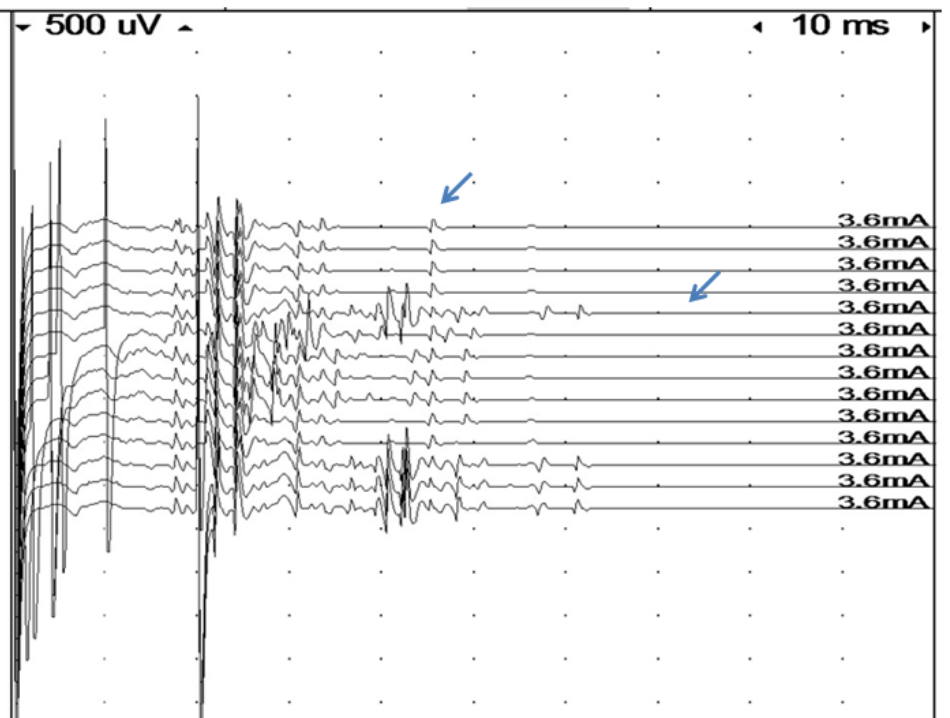
Figure 1. Intramuscular recordings of responses elicited using muscle (dm) and nerve (ne) stimulation in three patients. A = normal, B = low-amplitude responses for both direct and indirect stimulation, C = discrepancy between direct and indirect response amplitude, indicating neuropathy.